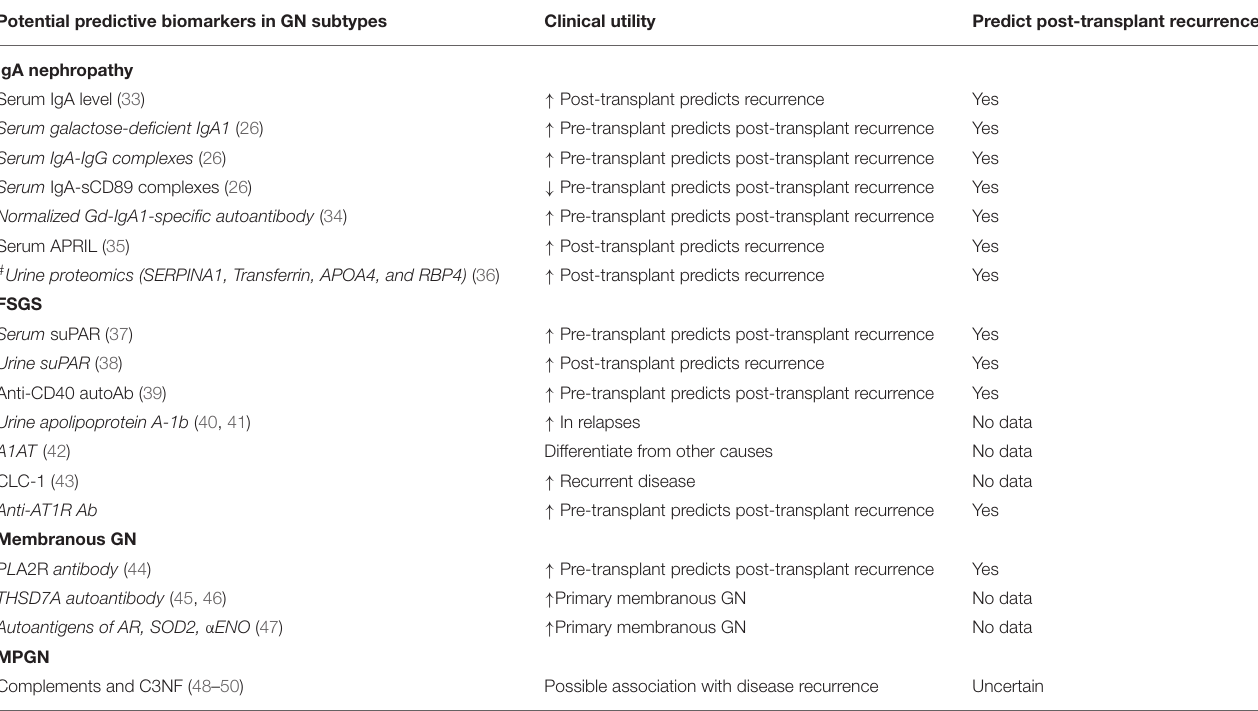
TABLE 2 | Prognostic and predictive biomarkers for glomerulonephritis and recurrence of disease post-kidney transplant. Potential predictive biomarkers in GN subtypes Clinical